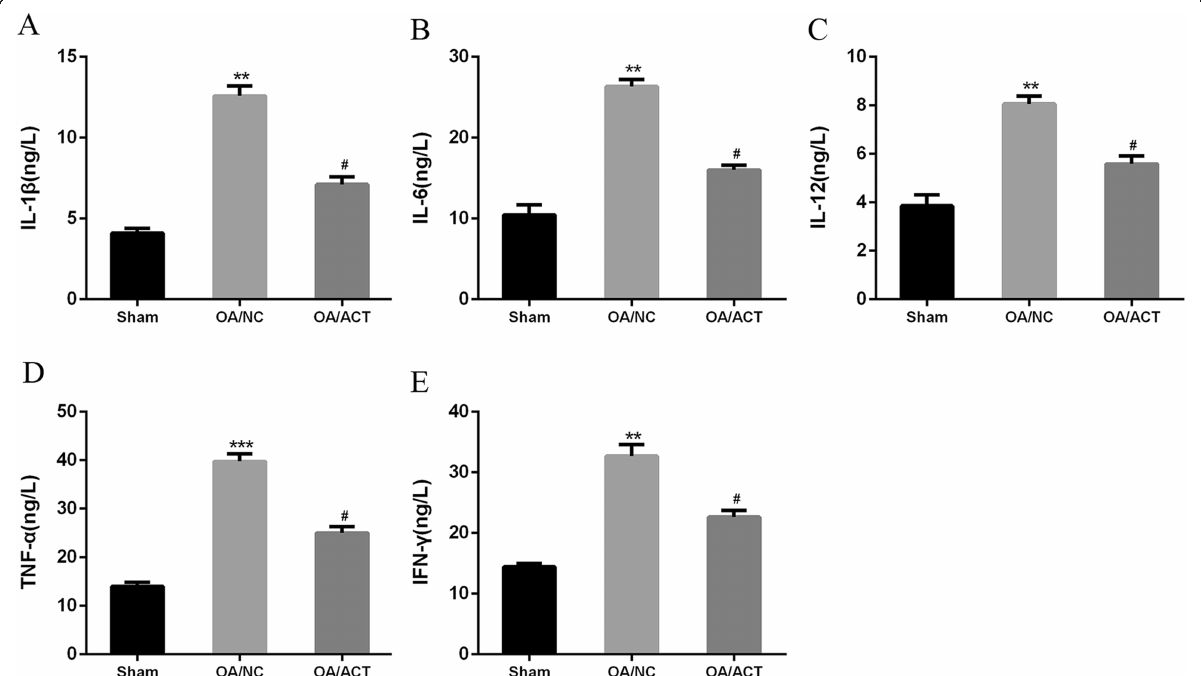
Fig. 5 ACT inhibits inflammatory cytokine production in synovial tissue of surgery-stimulated OA rats. SD rats were surgery-stimulated to induce OA and treated with ACT (100 mg/kg, i.p. injection). The generations of ( a ) IL-1 β , ( b ) IL-6, ( c ) IL-12, ( d ) TNF- α and ( e ) IFN- γ in synovial fluid of knee joint were measured by ELISA assay. ** p < 0.01 and * p < 0.05 compared with sham group. # p < 0.05 compared with OA/NC group. The experiment was repeated three times and the representative results were